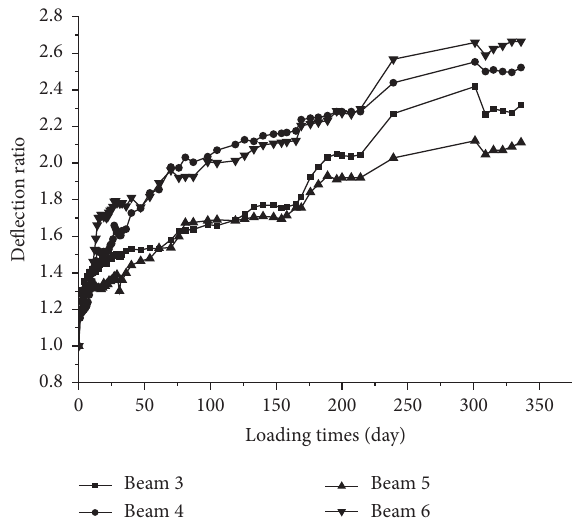
Figure 7: Curves of beam deflection under sustained